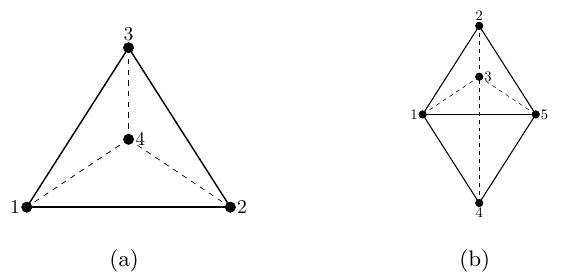
Figure 5 . Both the tetrahedron and the triangular bipyramid are cyclic polytopes.